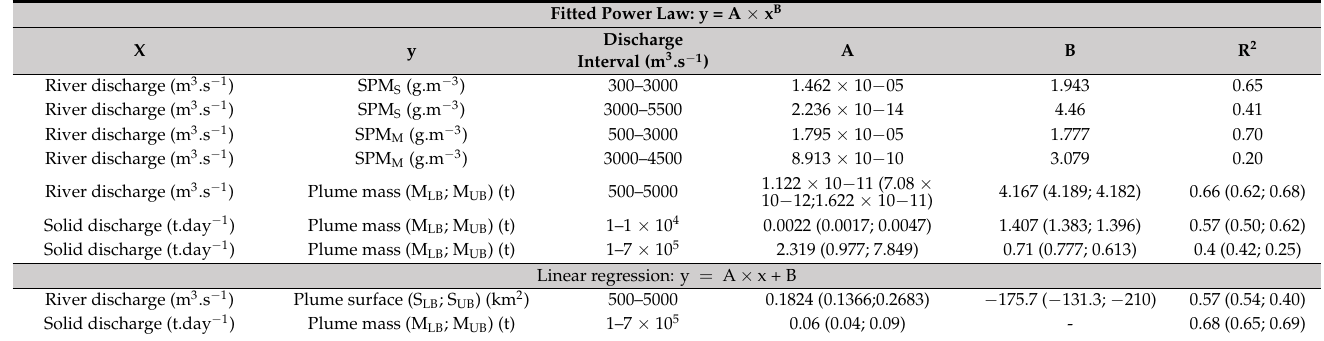
Table 4. Fitted coefficients for the relationships obtained between the Rh ô ne River liquid and solid discharge and the SPM concentration at SORA and MesuRho, the plume surface, and the SPM mass (Figures 10 and 11). Coefficients for relationships obtained with the surface (SLB; SUB) and mass (MLB; MUB) lower and upper bounds are also indicated in parentheses (obtained with a plume boundaries SPM concentration threshold at 4 and 2 g.m − 3 ,